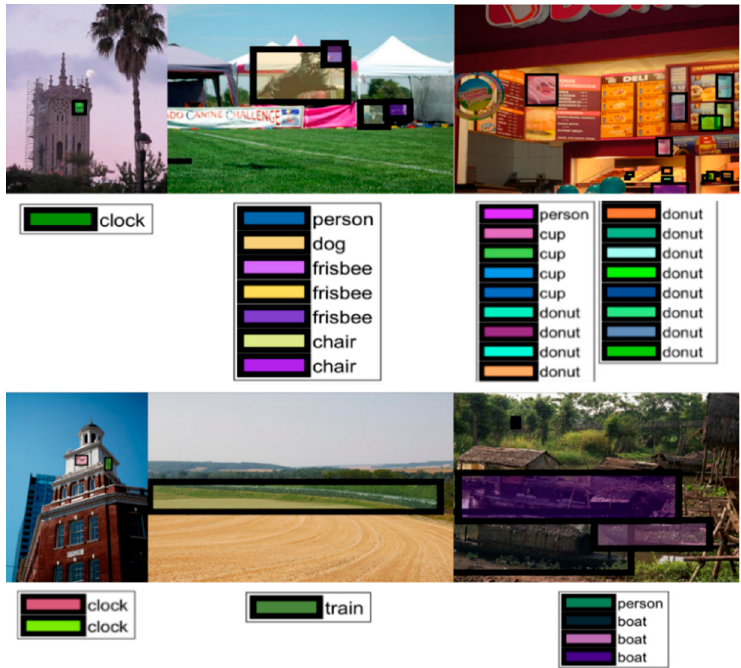
Figure 11. The ground truth of misdetections. Sensors 2020 , 20 , x FOR PEER REVIEW